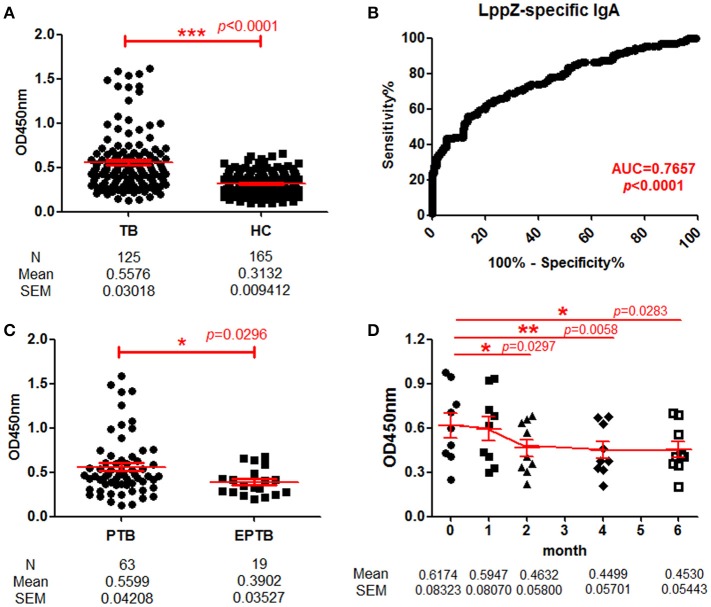
Determination of LppZ-specific IgA level in TB patients. (A) Comparison of optical density (OD450)-values of LppZ-specific IgA in the plasma between TB patients (N = 125) and HCs (N = 165). The P-value was calculated using Mann-Whitney test. (B) Receiver operating characteristic (ROC)-curve for LppZ-specific IgA to discriminate TB (N = 125) from HCs (N = 165). Area under curve (AUC) was 0.7657 (95% CI, 0.7096–0.8218). (C) Comparison of OD450-values of LppZ-specific IgA in pulmonary TB (PTB) patients (N = 63) and extra-pulmonary TB (EPTB) patients (N = 19). The P-value was calculated using Mann-Whitney test. (D) Cumulative OD450-values of LppZ-specific IgA in TB patients (N = 9) over the course of anti-TB treatment, including the time of diagnosis (month 0) and the time points at month 1, 2, 4, 6 during the treatment. The P-value was calculated using paired t-test. *0.01 < p < 0.05, **0.001 < p < 0.01, ***p < 0.001.